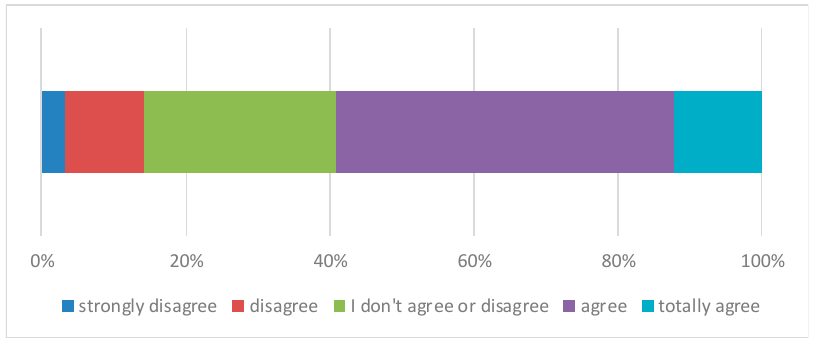
Figure 10. At the end of the second year of the baccalaureate, the student considers him/herself